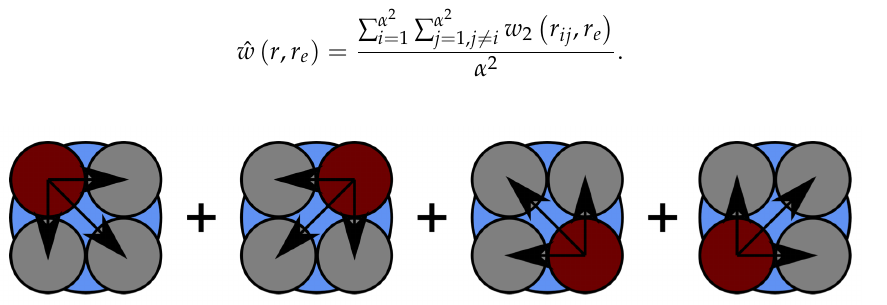
Figure 4. Calculation of the kernel function for inner particle